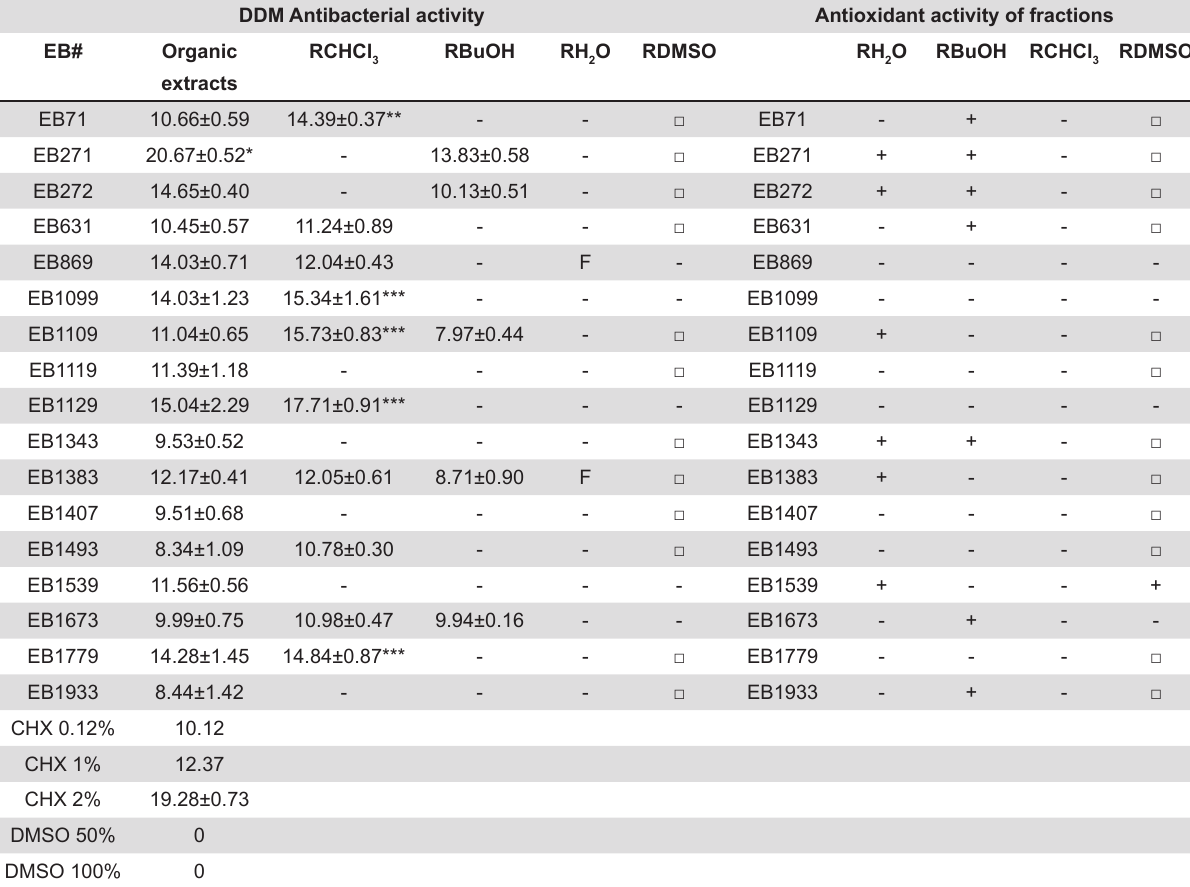
Table 1- Antibacterial activity observed for organic extract and its fractions diluted to 200 mg/mL against Streptococcus mutans in the disk diffusion assay in brain heart infusion agar-blood. Means and standard deviation values obtained from the growth-inhibition zone diameters are given and are expressed in millimeters (n=6; ntotal=120). One-way ANOVA and Tukey's post test were used to compare means (significant if p<0.05). *significance is indicated as a comparison of test samples to 1% CHX . Antioxidant activity observed for fractions obtained from active plant